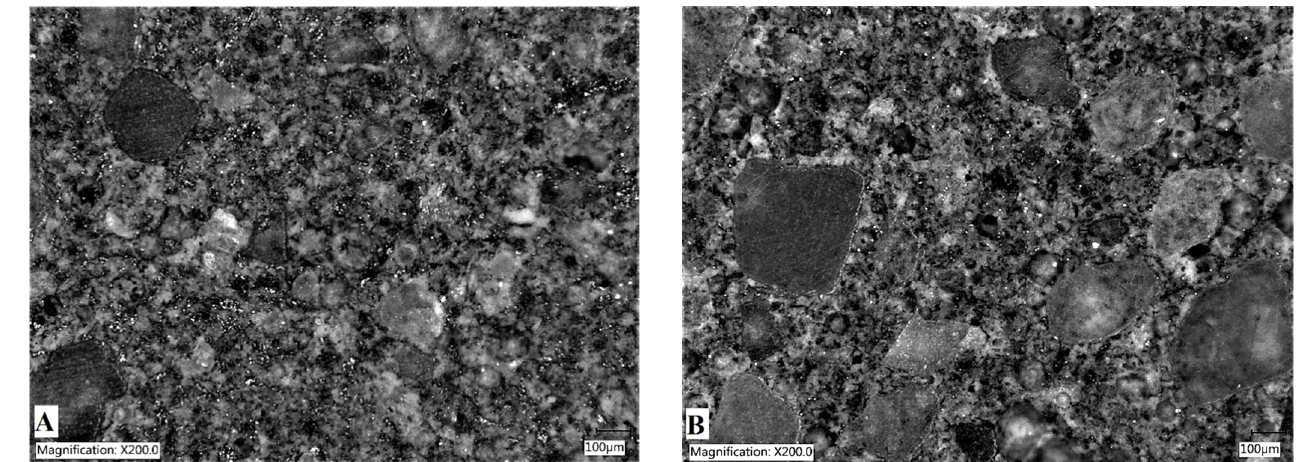
Figure 5. Microscopy images of composites with graphite content: ( A ) 2 wt% and ( B ) 1 wt%; graphite particle—black color, cement matrix and sand—lighter color.